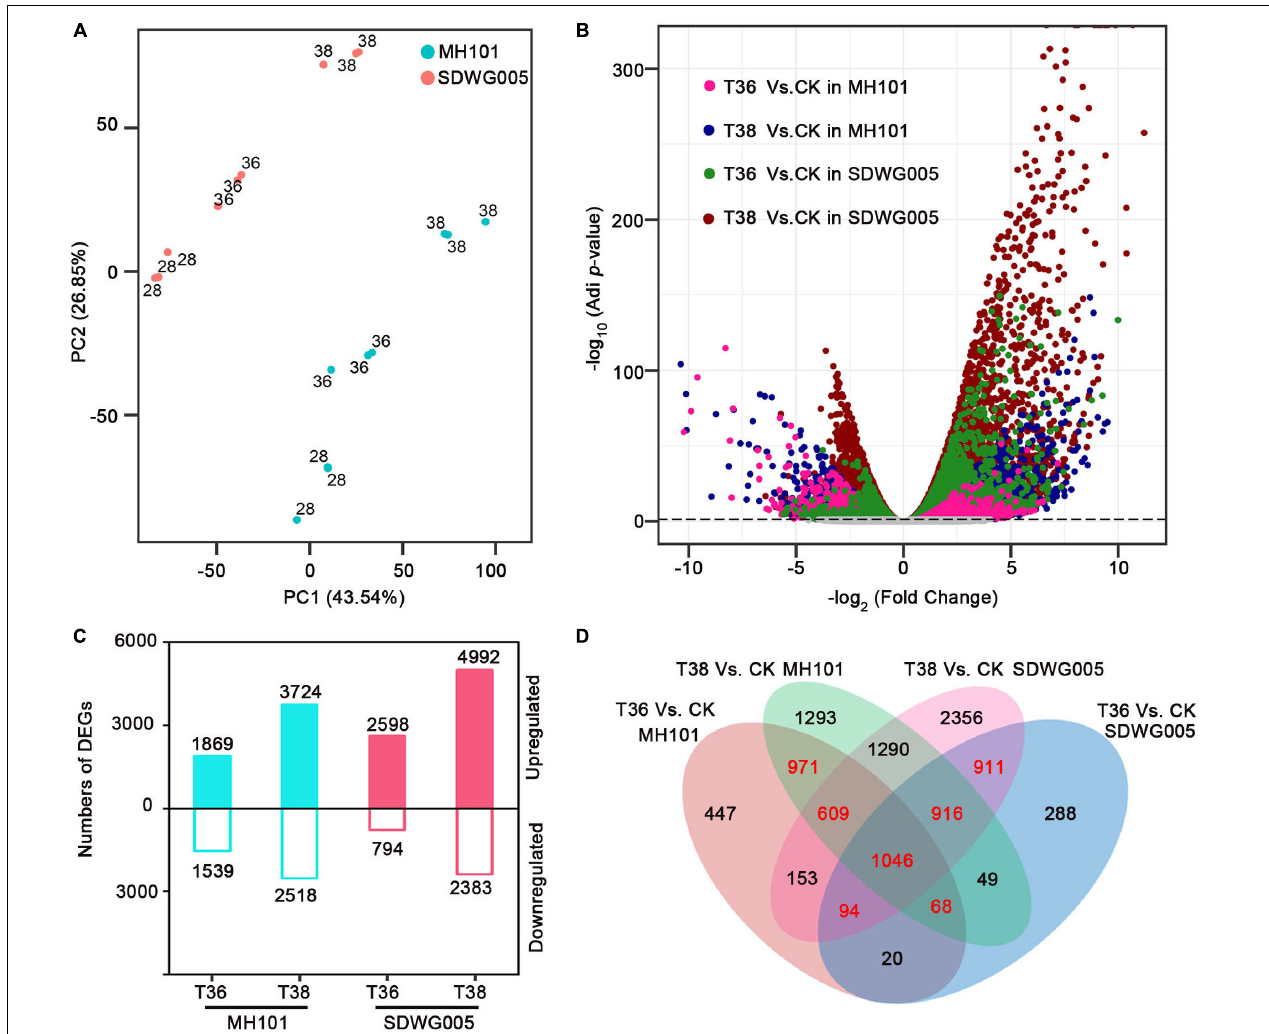
FIGURE 3 | Analysis of DEGs in rice varieties in response to heat stress. (A) PCAs of log 2 transformed raw read counts for CK, T36, and T38 for MH101 and SDWG005, respectively. (B) Volcano plot of expressed genes under different heat stress. Log 2 transformed FC was plotted against the -log 10 transformed adjusted P -value. Pink, blue, green and red dots represent DEGs of T36 relative to CK in MH101, T38 relative to CK in MH101, T36 relative to CK in SDWG005, T38 relative to CK in SDWG005, respectively. The gray line represents the –log 10 transformed adjusted P -value cutoff. (C) Number of up- (log 2 FC ≥ 1 and FDR adjusted P -value ≤ 0.05) and down-regulated (log 2 FC ≤ -1 and FDR adjusted P -value ≤ 0.05) DEGs detected under different heat stress treatments relative to control for MH101 and SDWG005, respectively. (D) Venn’s diagram of the comparison of DEGs under different heat stress treatments in MH101 and